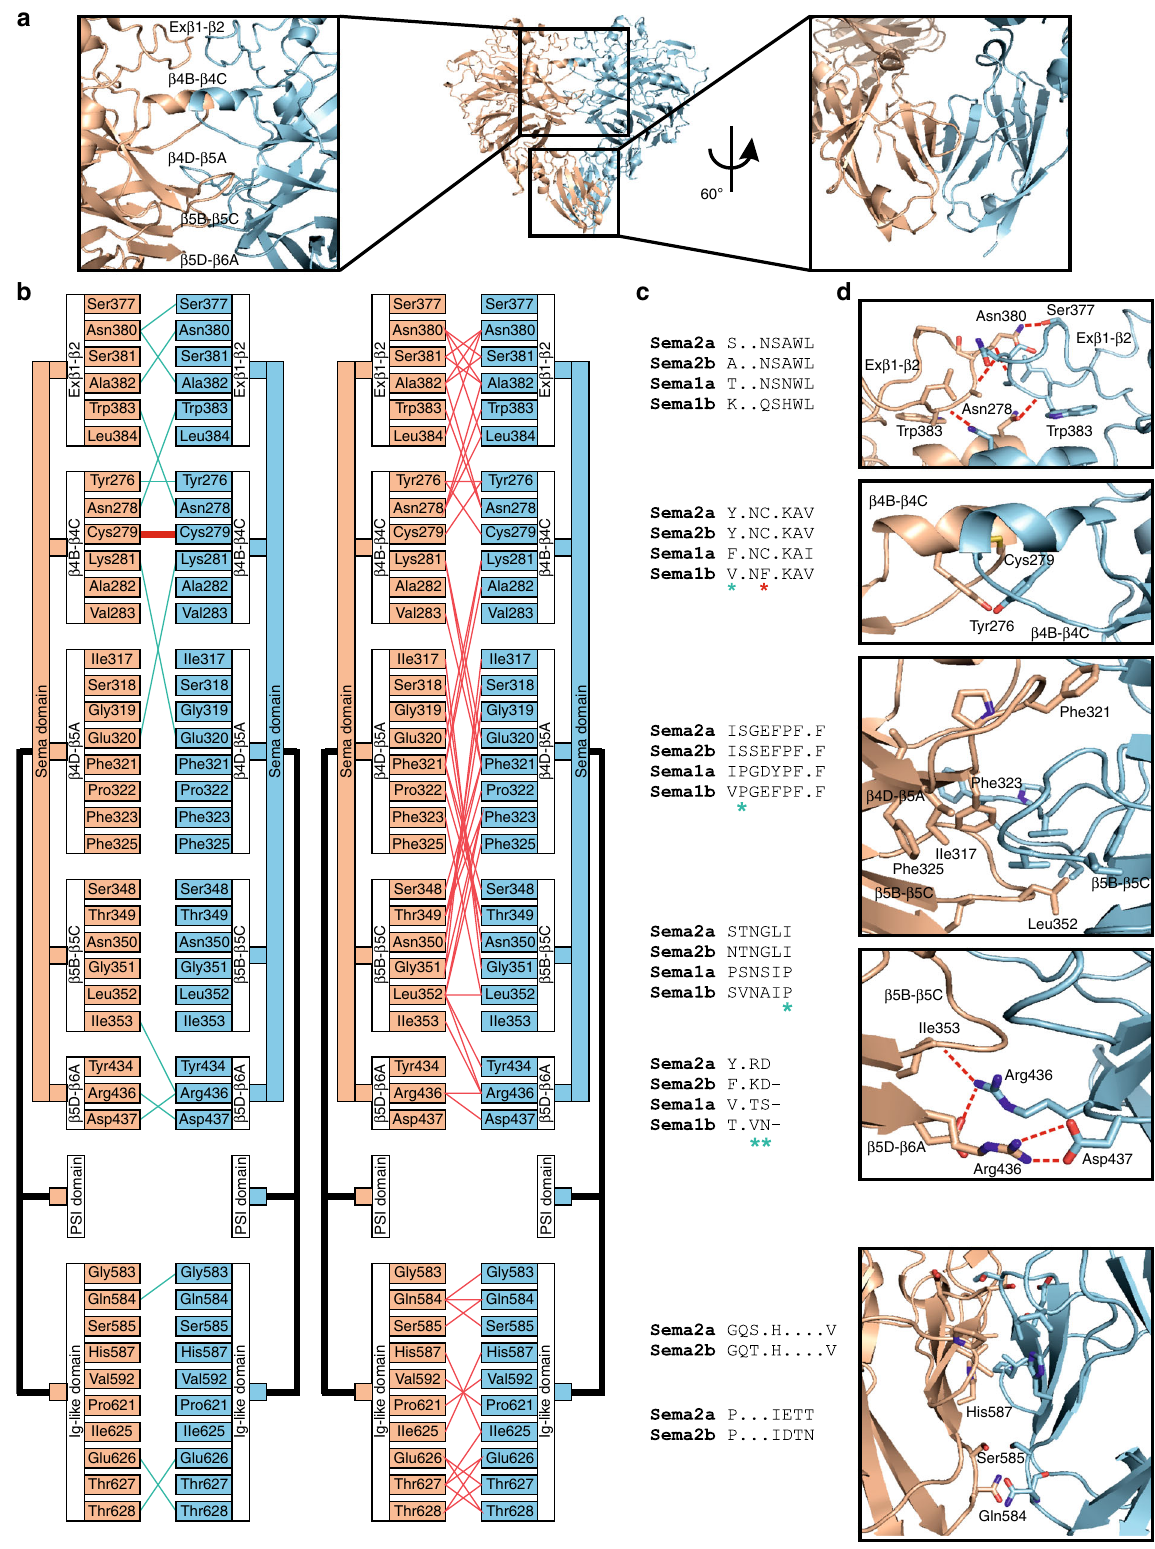
Fig. 3 Protein – protein interaction at the Sema2a 1 – 3 homodimer interface. a Ribbon representation of the Sema2a 1 – 3 crystal structure with two zoom-in views showing a face-to-face interaction between the top surfaces of the sema domains formed by fi ve protruding loops (left) and intermolecular interaction between Ig-like domains (right). b Details of intermolecular interactions depicted in (A). The left panel shows the interchain disul fi de bond (red) and intermolecular hydrogen bonds while the right panel shows the other non-bonded contacts. c Sequence alignment of the residues involved in the Sema2a homodimerization from Drosophila semaphorins. The class-speci fi c differences in propensity to dimerize can be explained by the class-speci fi c residues that are shown by asterisks. d Close-up views of the Sema2a 1 – 3 homodimer